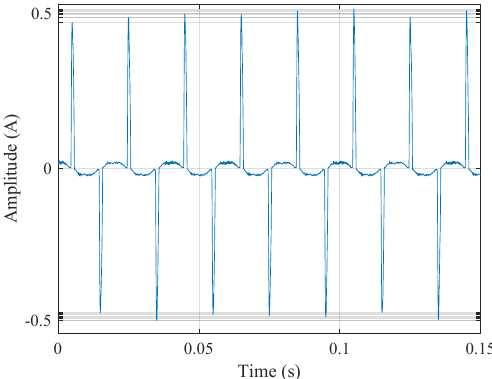
Figure 1. Illustration of a random SMPS current for a constant